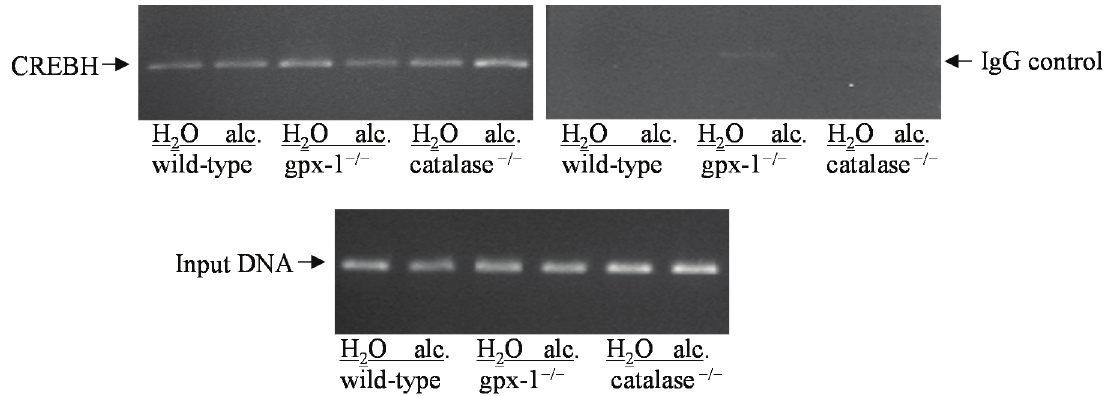
Figure 7. CREBH binding to hepcidin gene promoter. Chromatin isolated from the livers of water (H 2 O) or ethanol (alc.)-fed wild-type mice and gpx-1 (cid:2)/(cid:2) or catalase (cid:2)/(cid:2) transgenic mice were immunoprecipitated by an anti-CREBH antibody or normal rabbit IgG, as control. The co-immunoprecipitated and total input (control) DNA were used as templates in PCR to amplify a 321 bp mouse hepcidin gene promoter region, which harbors CREBH DNA-binding site, as described in Experimental